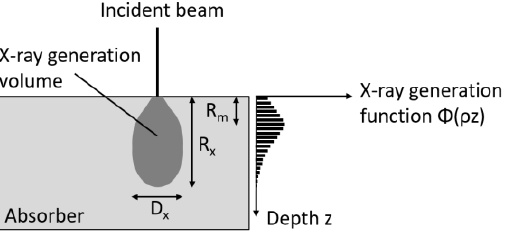
Figure 3. Schematic representation of X-ray range R x , R m , and D x .